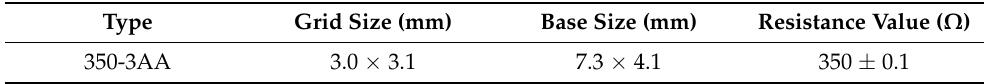
Table 1. Strain gauge sensor parameters.